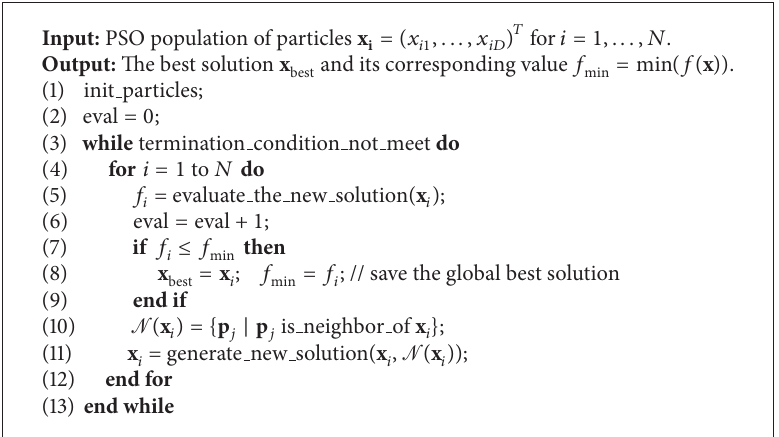
Algorithm 4: The proposed RDF-PSO